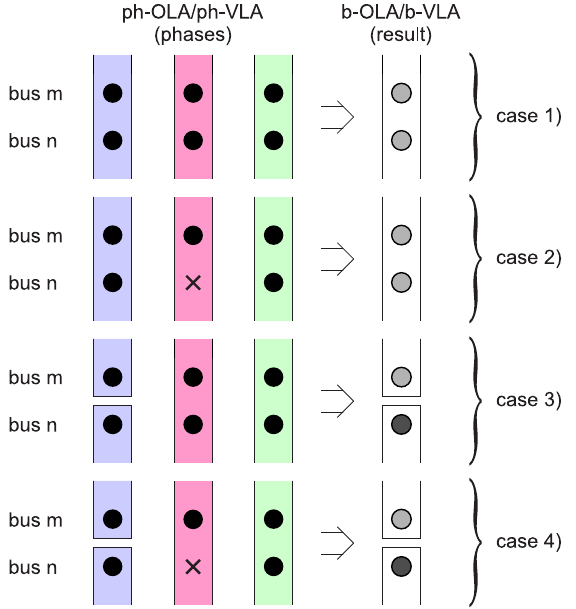
Figure 5. From phase to bus clusters (either OLAs or